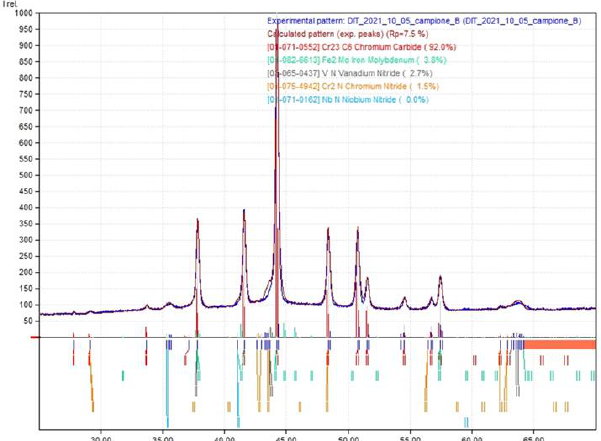
Figure A1. Failed crept cross-weld specimen 91-HAZ-3-5 600 °C 112 MPa 3216 h (sample B). XRD analysis.